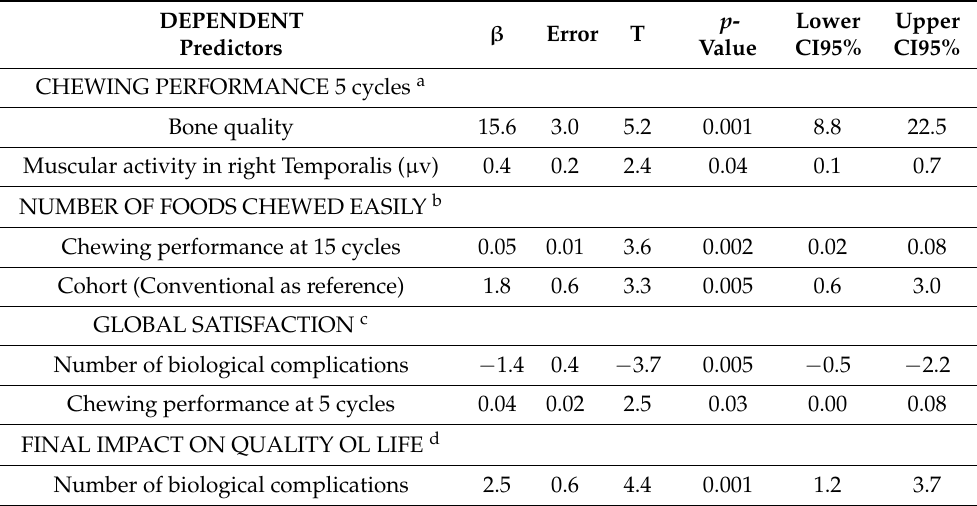
Table 13. Linear Regression Analyses for predicting the clinical and patient-centered treatment outcomes as a function of the age, sex, cohort, bone quality, final masticatory performance, final chewing ability, satisfaction, quality of life, final occlusal area, final occlusal load, and muscular activity ( n =